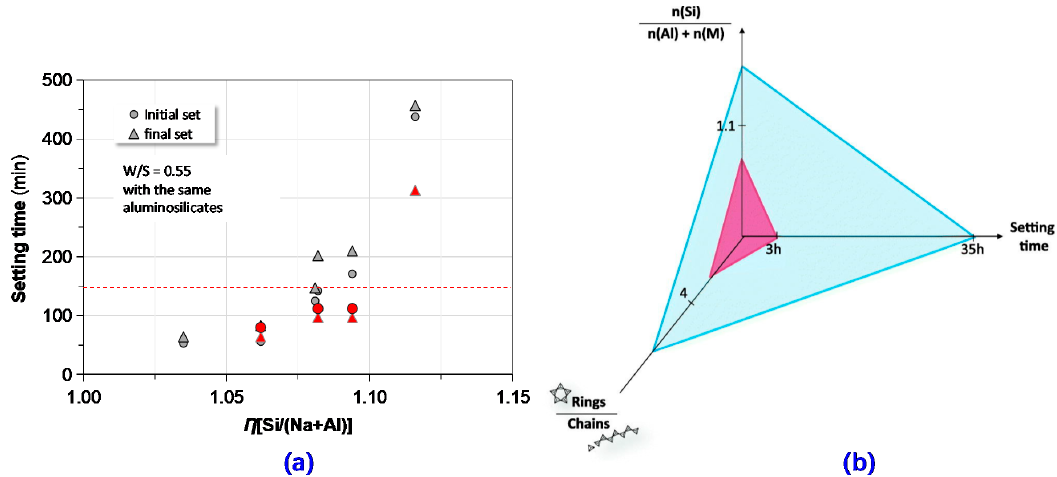
Figure 6. Correlating η [Si / (Na + Al)] to setting time of GPC: ( a ) setting time vs. η [Si / (Na + Al)] in this study alongside the reported data; ( b ) setting time vs. η [Si / (Na + Al)] reported in previous literature [48].